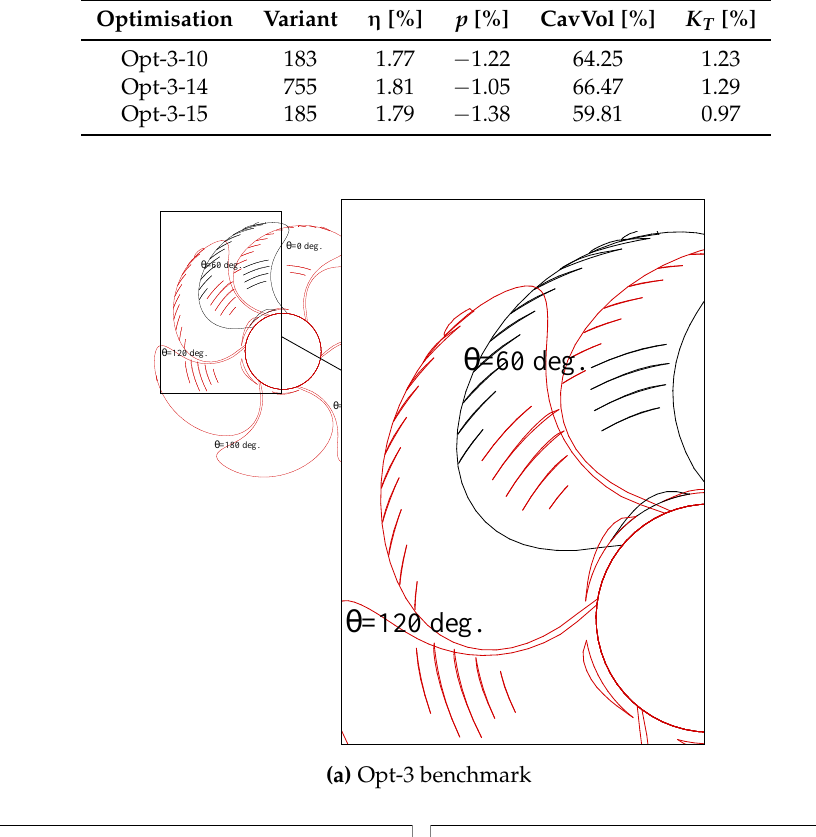
Table 10. Pareto optimal solutions of Group 3, relative to performance of manual design.